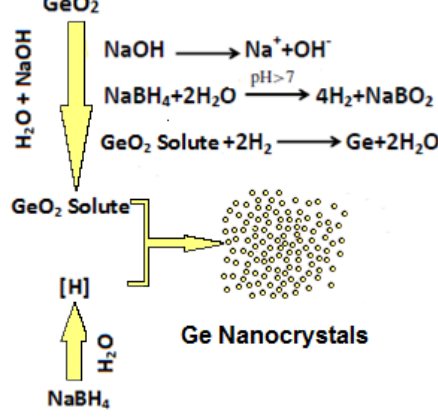
Fig. 1 The reaction of NaBH